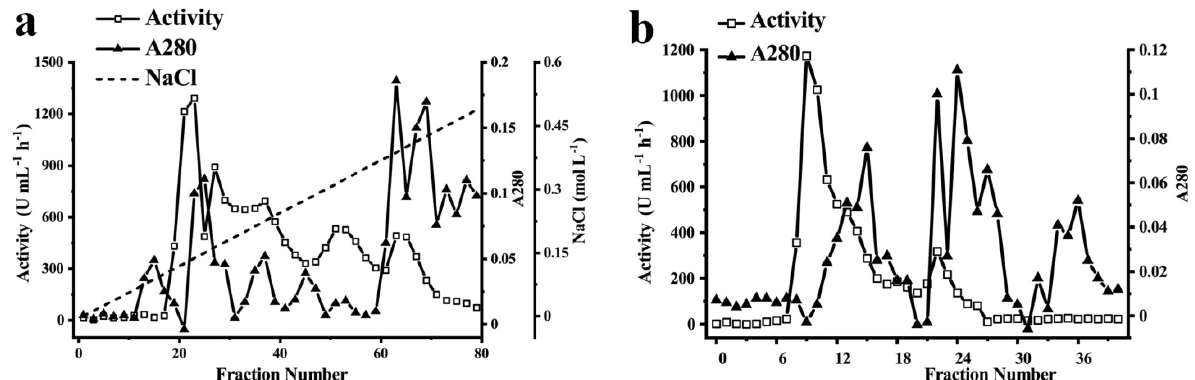
Figure 2. Purification of polyphenol oxidases from Huaniu peel. ( a ) Protein content (A280 nm) and activity determined in DEAE-sepharose column-chromatography fractions. Linear increase in NaCl concentration (0–0.6 M) during elution is also shown. We collected the major activity fractions for further purification. ( b ) Total protein (280 nm) and activity determined in Sephadex G-200 column- chromatography fractions. We collected the fractions in the major activity peaks for the following analysis. ( a , b ) We determined the activity in the fraction with EC as substrate. Table 1. Purification of polyphenol oxidase from Huaniu peel.